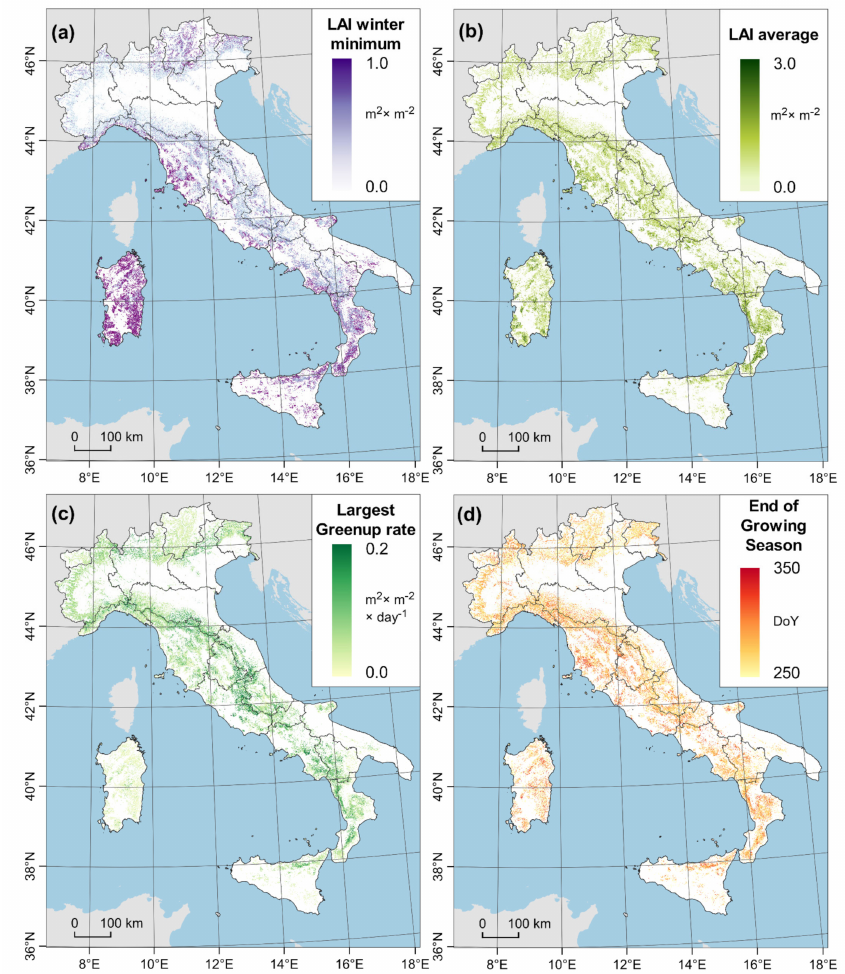
Figure 4. Maps of selected phenological metrics estimated for the study area (year 2019). ( a ) LAI winter minimum; ( b ) LAI average; ( c ) Largest Greenup rate; ( d ) End of Growing Season date. Table 4. Accuracy assessment results for the comparison of phenological metrics estimated